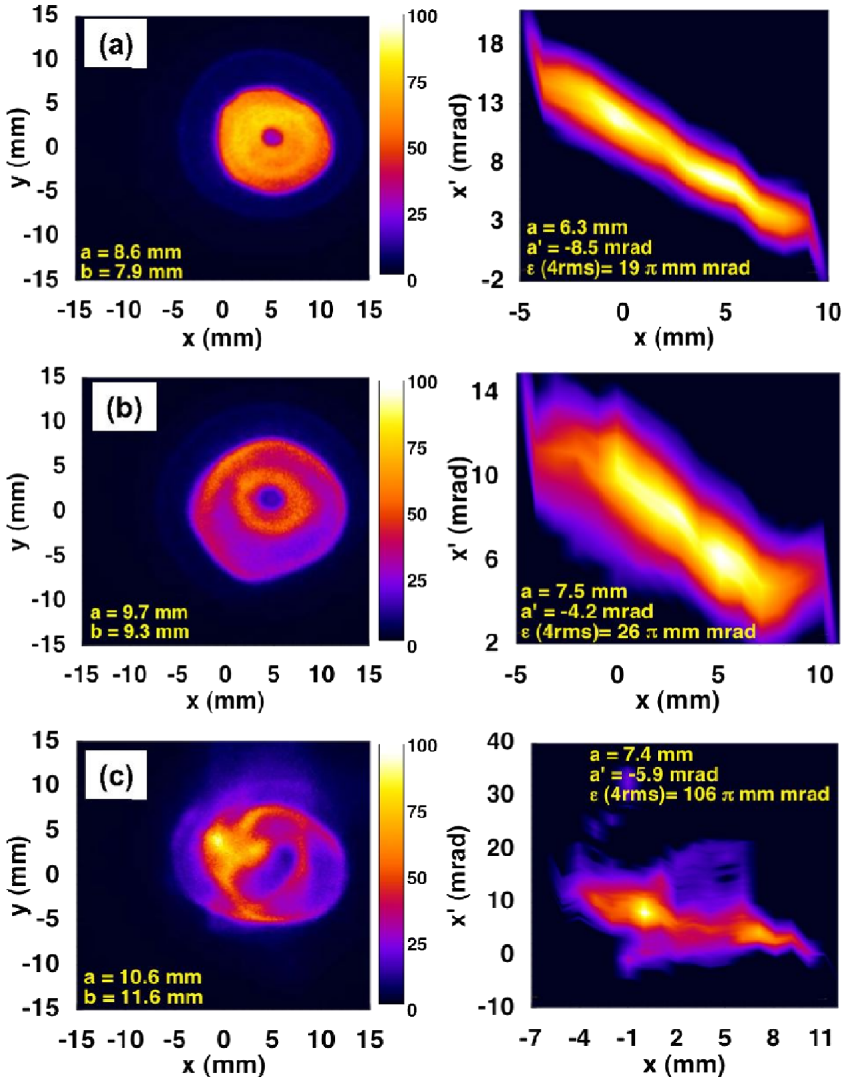
FIG. 10. (Color) Left column: measured transverse beam distribution 56 cm downstream of the exit of four solenoids ( z (cid:5) 306 cm ); right column: measured transverse phase space 40 cm downstream of the exit of four solenoids ( z (cid:5) 290 cm ; note scale differences) for: (a) clearing case; (b) grounded case; (c) trapping